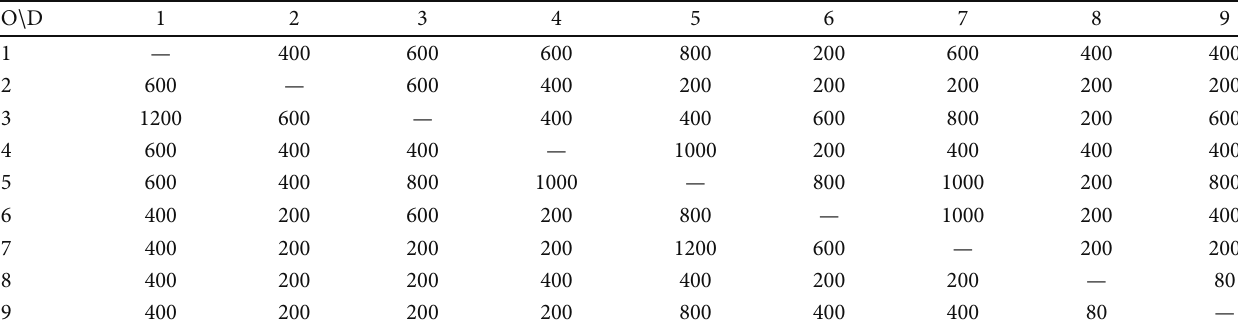
Figure 13: A multimodal network from Jiangning District in Nanjing. Table 1: Total OD demand of the multimodal system in Figure